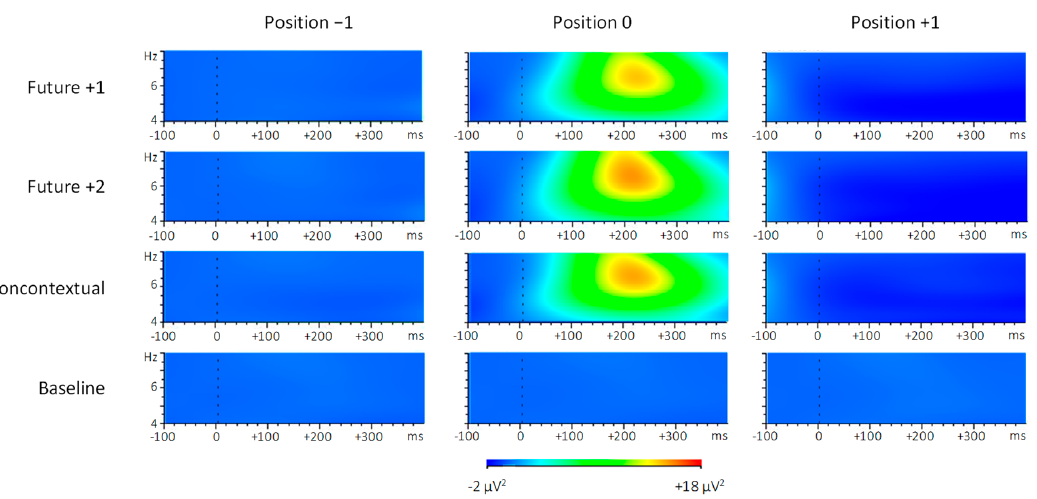
Figure 7. Evoked spectral power within the 4-8 Hz (theta) frequency range following pitch onsets at target event positions − 1, 0, and +1. Brighter colors indicate greater spectral power.